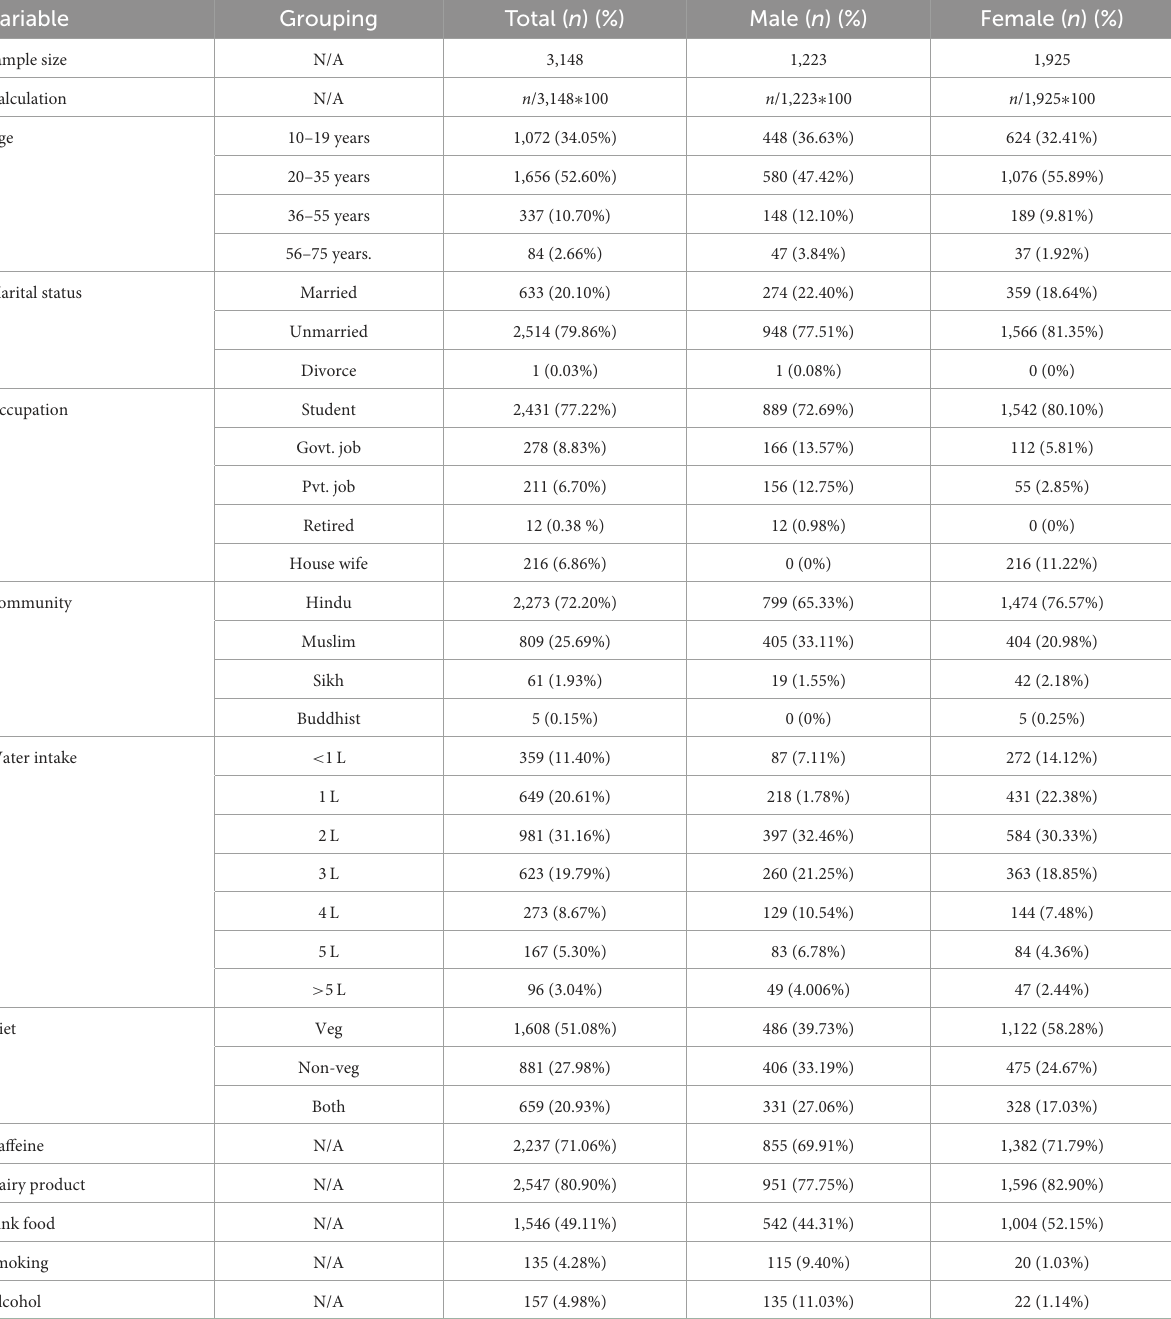
TABLE 3 Frequency distribution of demographic